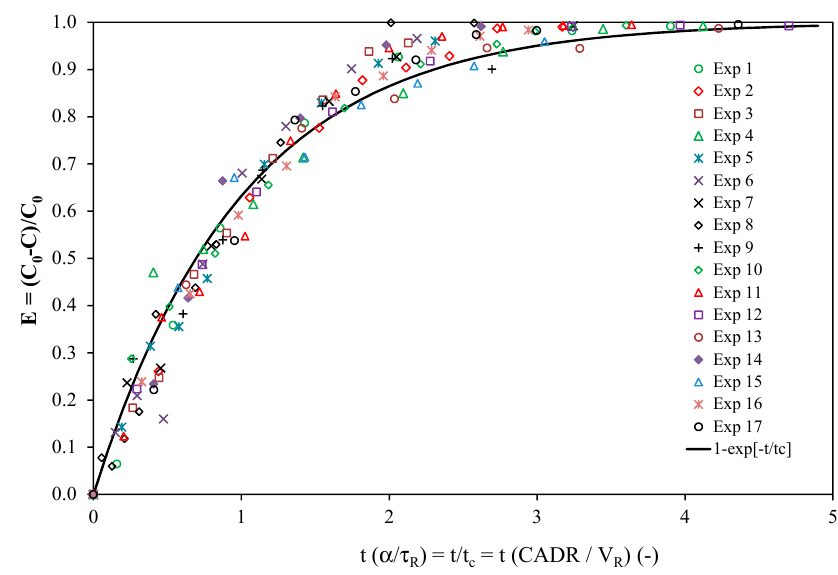
Figure 4. Toluene removal efficiency for all experiments according to the generalized form (Equation (4)). Molecules 2017 , 22 , 408